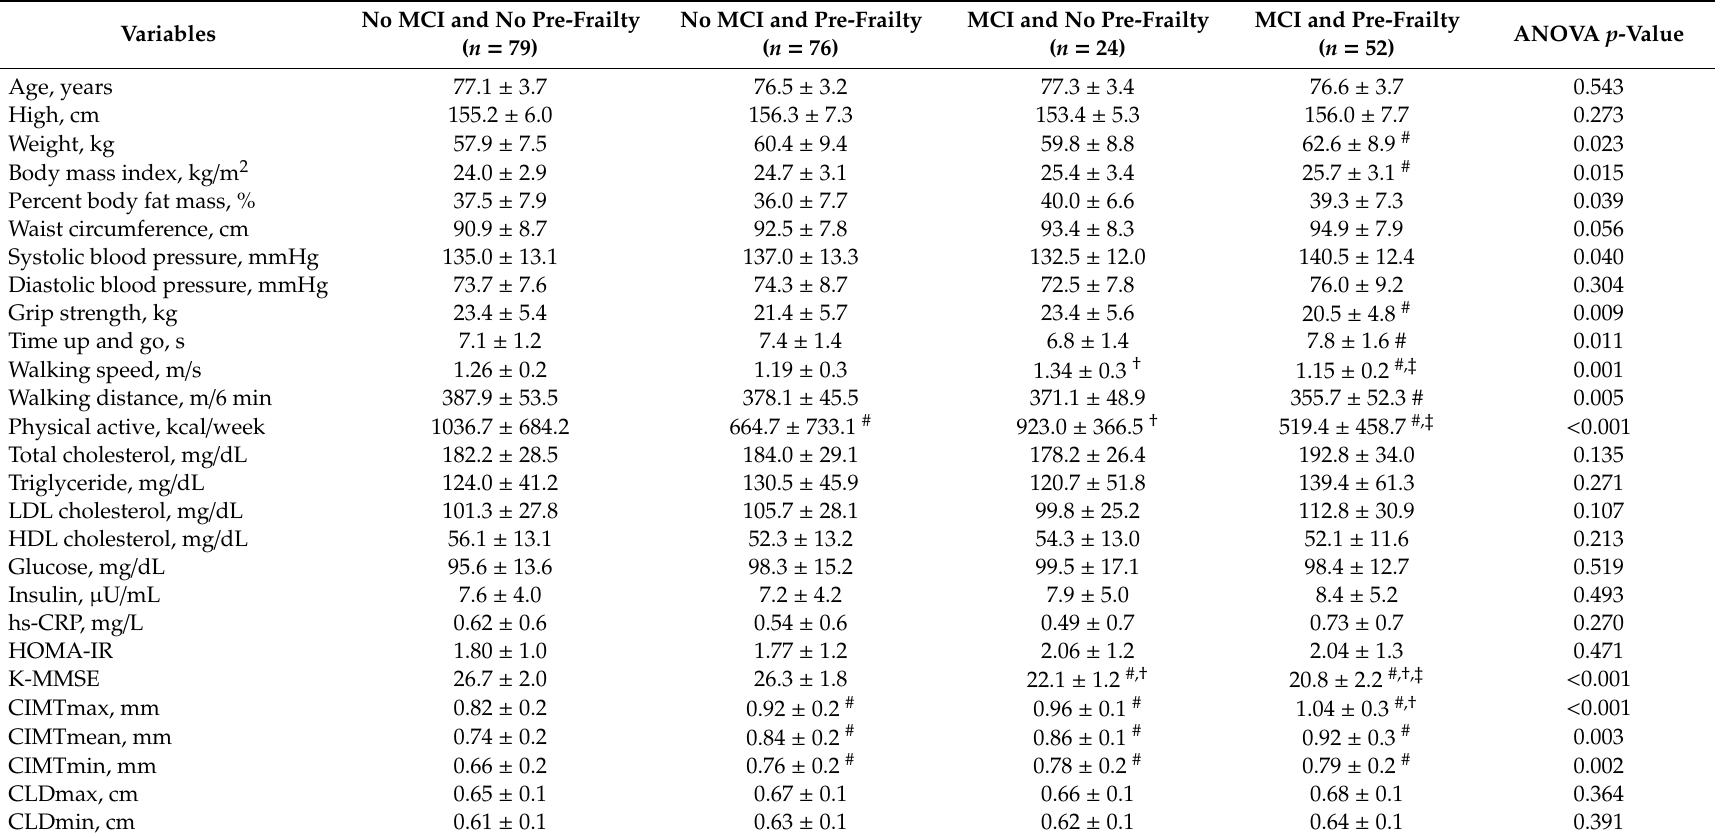
Table 3. Di ff erences among groups of variables according to the cognitive function and frailty